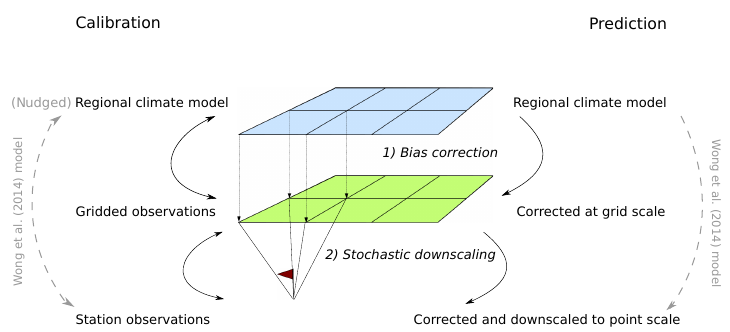
Figure 1. Schematic of (black) our combined statistical bias correction and stochastic downscaling model, and (grey) the Wong et al. (2014)